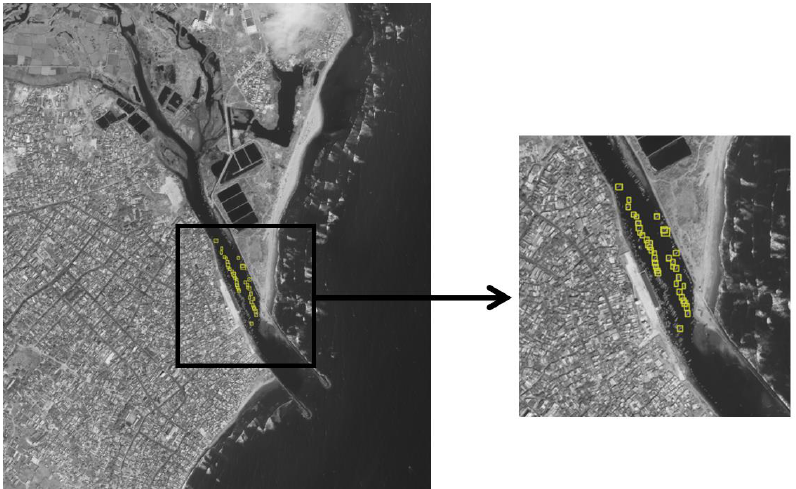
Figure 12. The detection performance for aircraft with modified Yolov5 in the original satellite im- age.